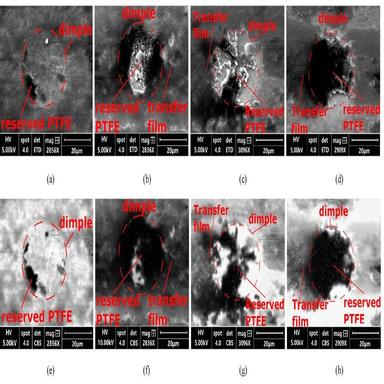
(a)- (d) SE images of Type B (narrow & shallow) dimples from run-in to steady stage (area 1-4 marked in); (e)-(h) BSE images of Type B (narrow & shallow) dimples from run-in to steady stage (area 1-4 marked in.